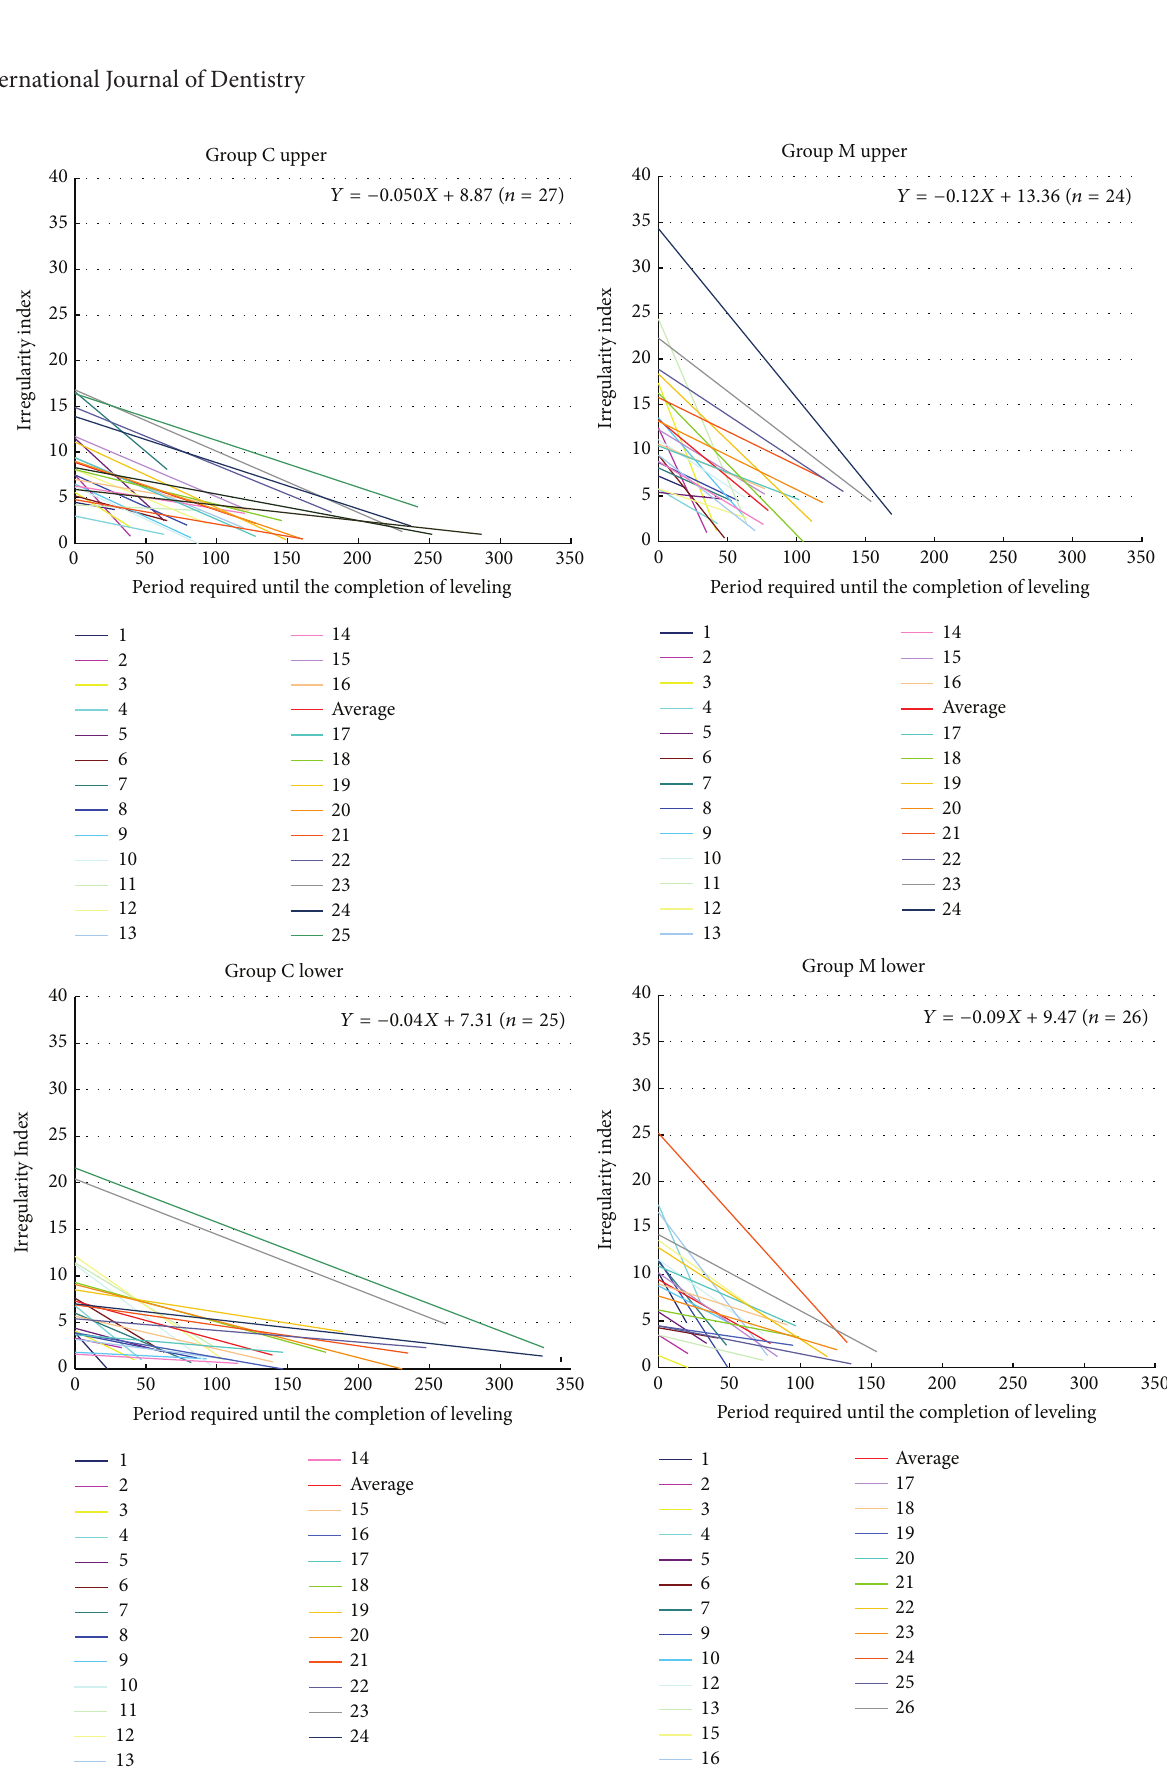
Figure 4: Linear functional formula expressing tooth